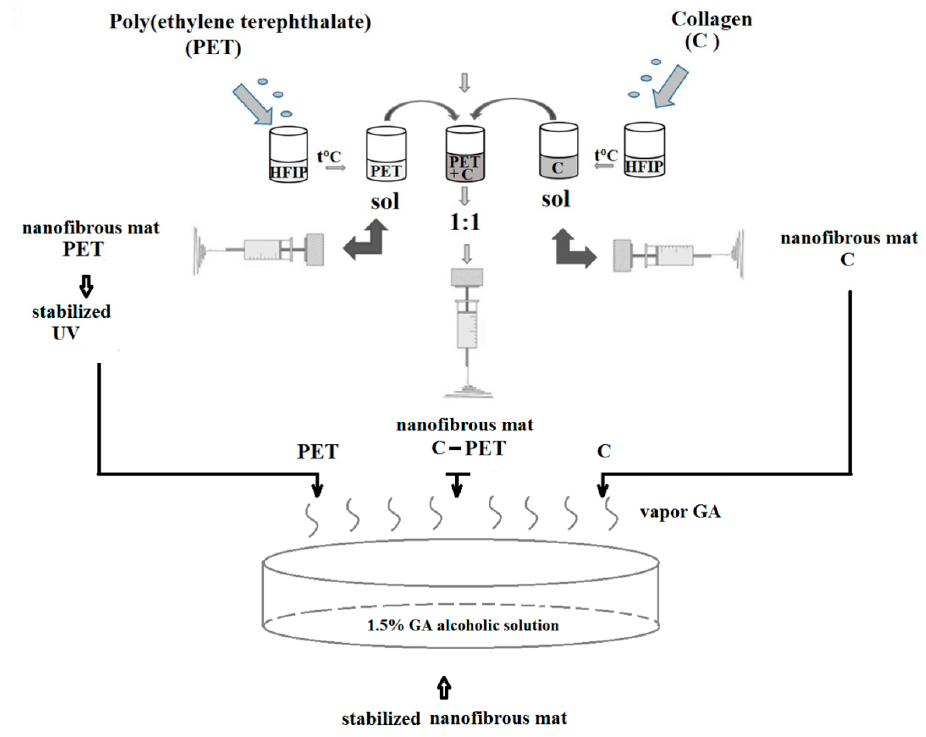
Figure 1. The preparation procedures for the solutions of polyethylene terephthalate (PET), collagen (C) and a combination of the two (C-PET) for electrospun fibers.